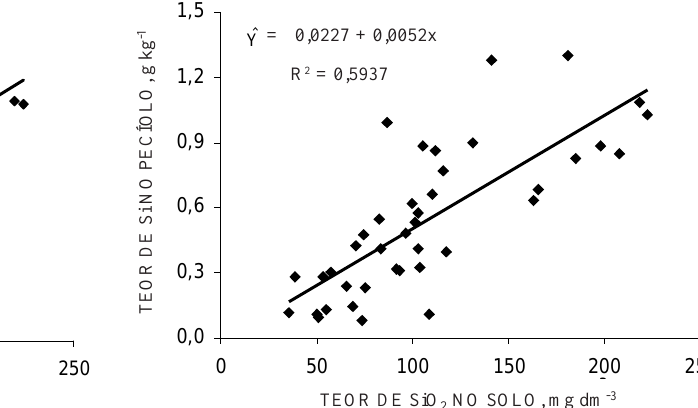
Figura 1. Correlação entre silício “disponível” no solo e teor de silício das folhas do tomateiro.